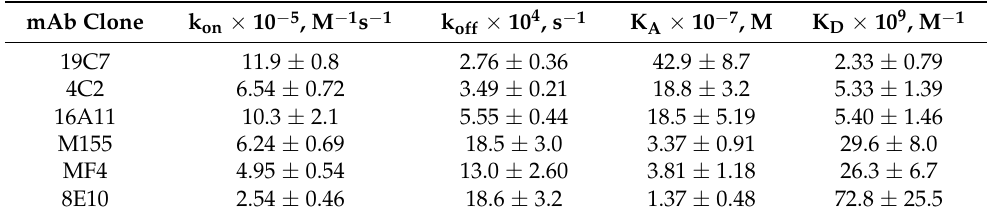
Table 1. Equilibrium and kinetic constants calculated for different clones of mAb to cTnI used as a capture